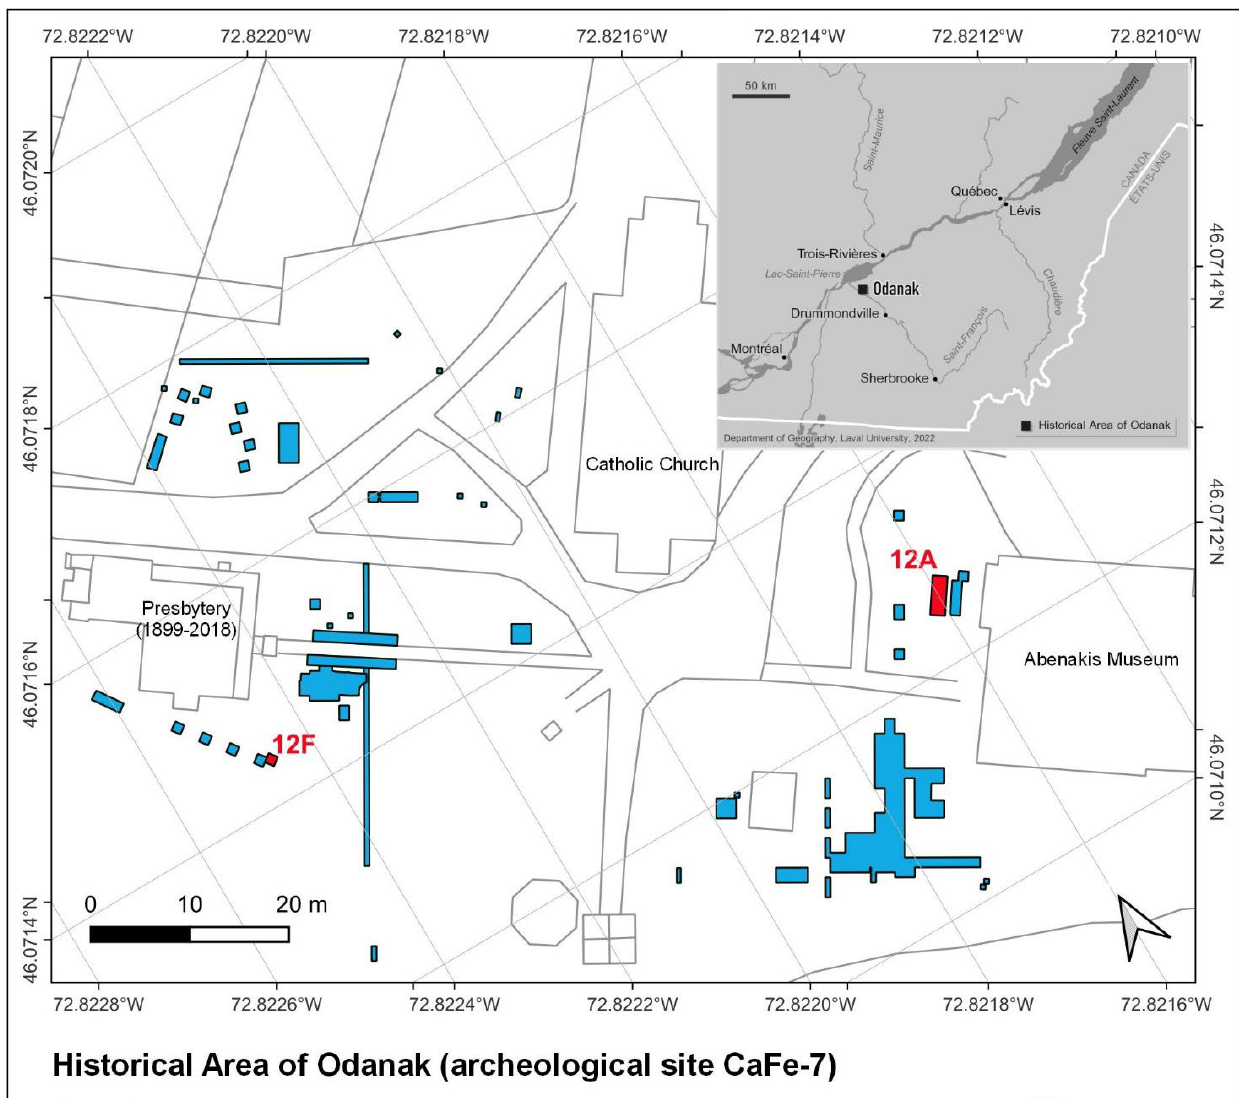
Figure 1. Map of the archaeological excavations conducted at the Fort Odanak site (CaFe-7) between 2010 and 2021 (Bureau du Ndakina, Grand Conseil de la Nation Waban-Aki, 2022; L. Marcoux, Université Laval, 2022).